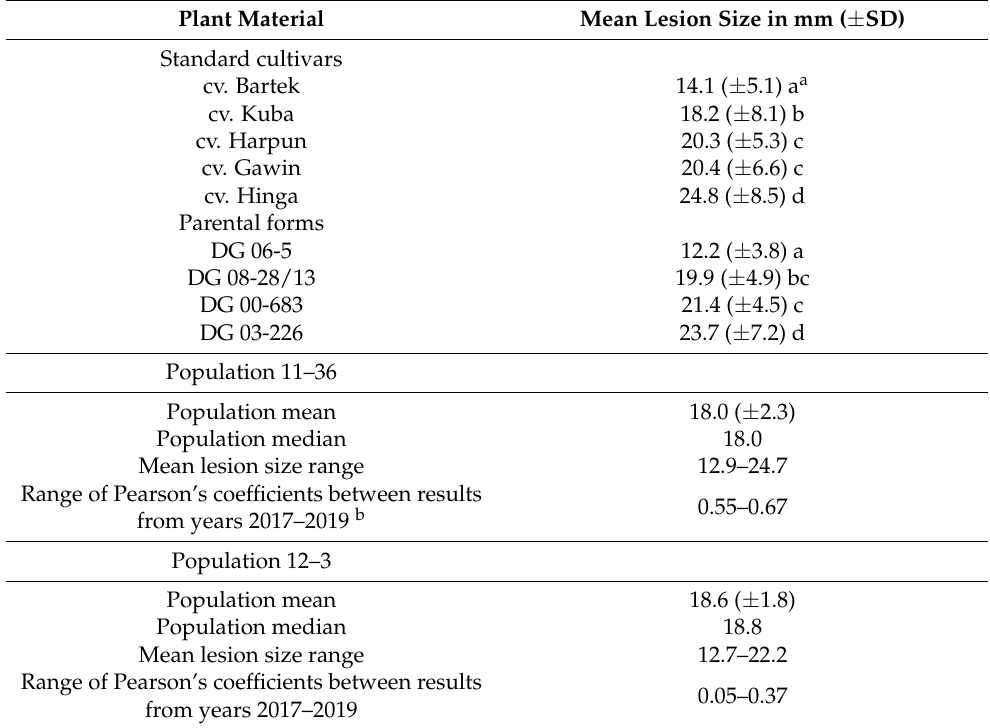
Table 1. Evaluation for Fusarium dry rot resistance of the standard potato cultivars, parental lines and individuals of the diploid potato populations 11–36 and 12–3. Mean results of three-year (2017–2019) measurements of a lesion sizes ( ± SD) caused by the F. sambucinum isolate MF1. Plant Material Mean Lesion Size in mm ( ± SD) Standard cultivars